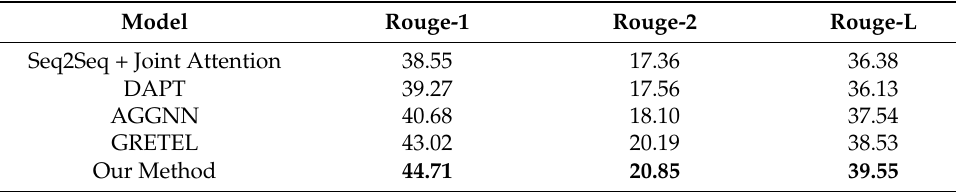
Table 3. Evaluation results of the baseline model on the MR dataset